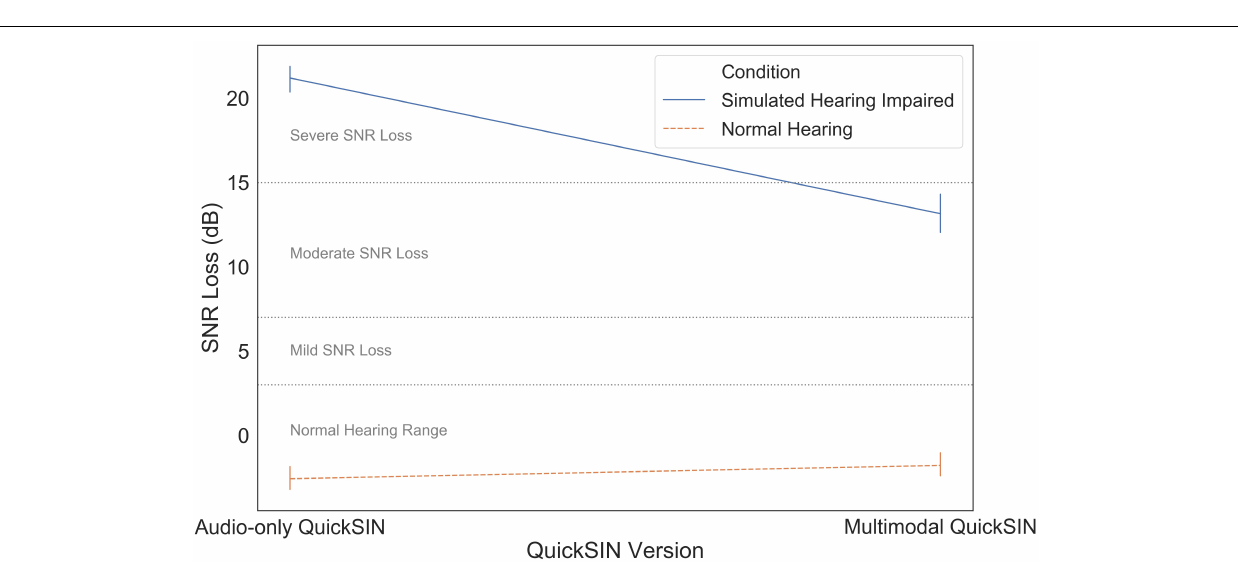
FIGURE 6 | SNR loss as a function of hearing impairment and QuickSIN